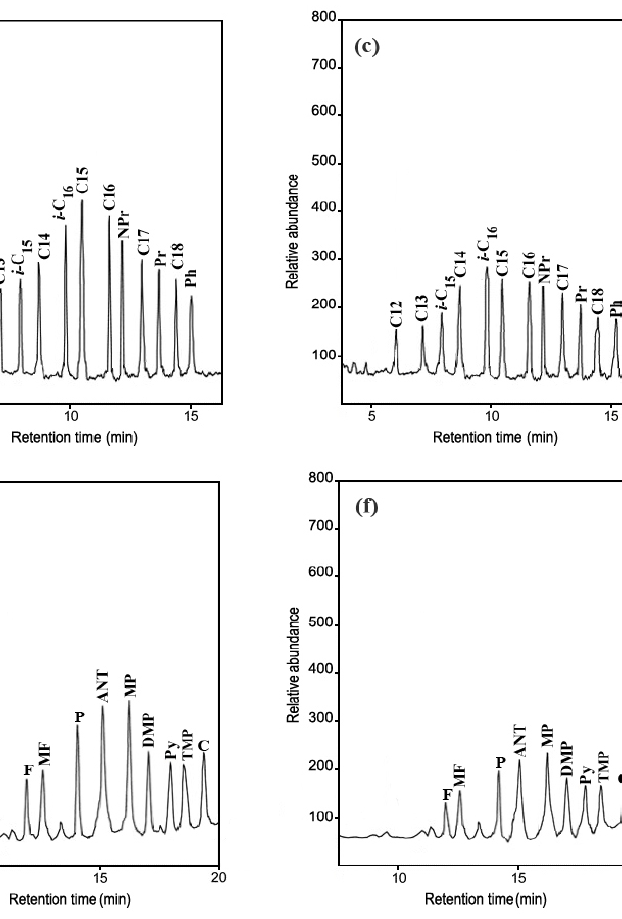
Figure 2. Gas chromatography–mass spectrometry (GC-MS) analysis of crude oil samples before and after biodegradation. ( a ) The aliphatic hydrocarbons of crude oil control; ( b ) biodegradation sample of A. terreus KC46206; ( c ) biodegradation sample of A. terreus KC46206 and Cu-ABTS. ( d ) The aromatic hydrocarbons of crude oil control; ( e ) biodegradation sample of A. terreus KC46206, ( f ) biodegradation sample of A. terreus KC46206 and Cu-ABTS, all treatments after 10 days.